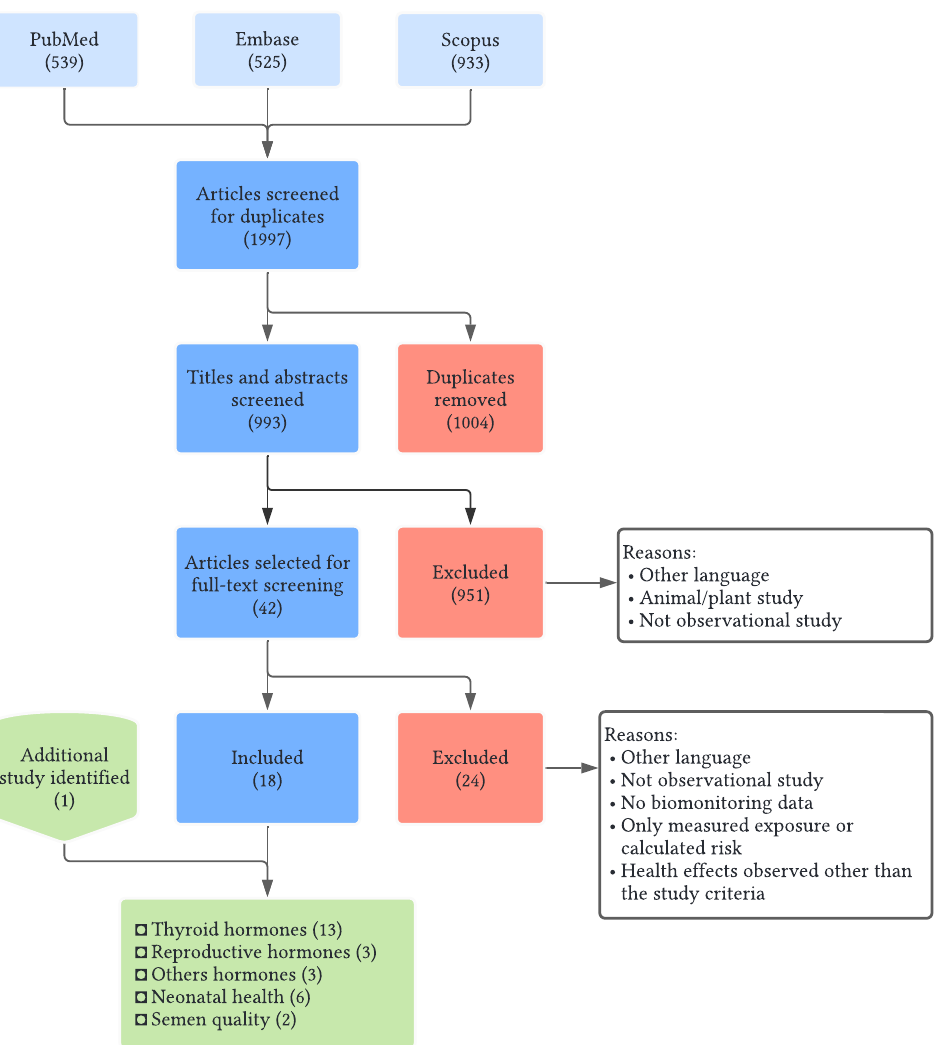
Figure 2. Literature search and screening